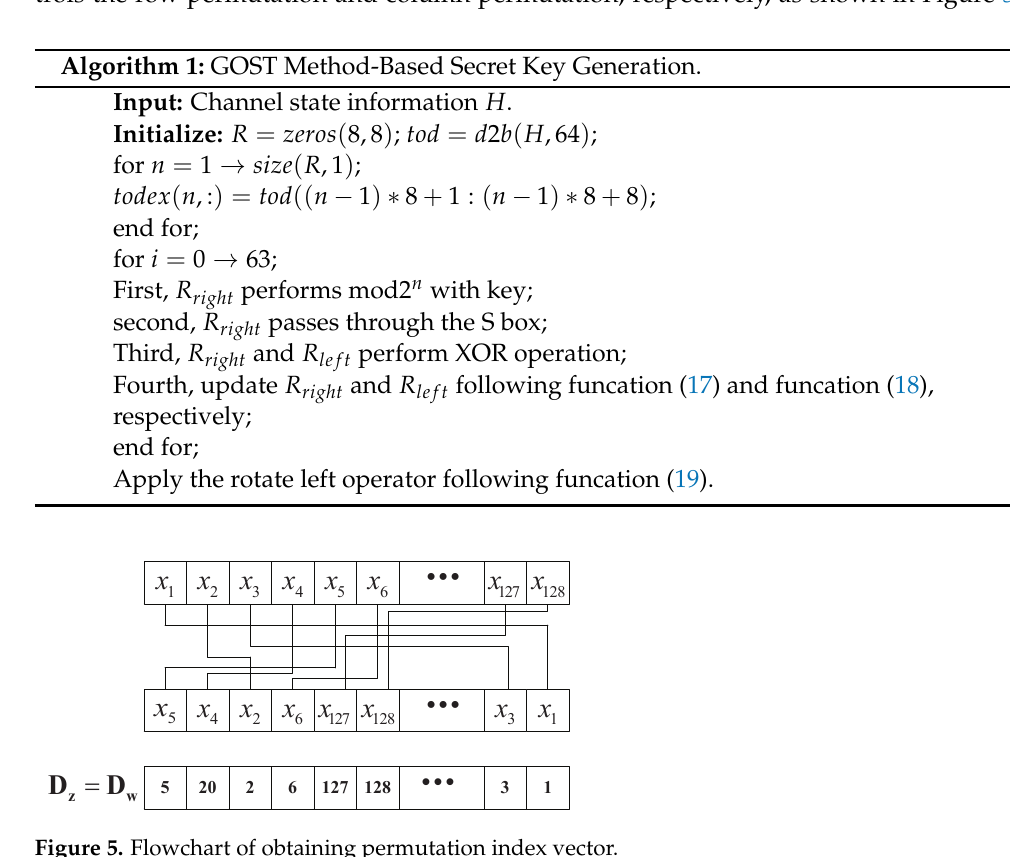
Figure 5. Flowchart of obtaining permutation index